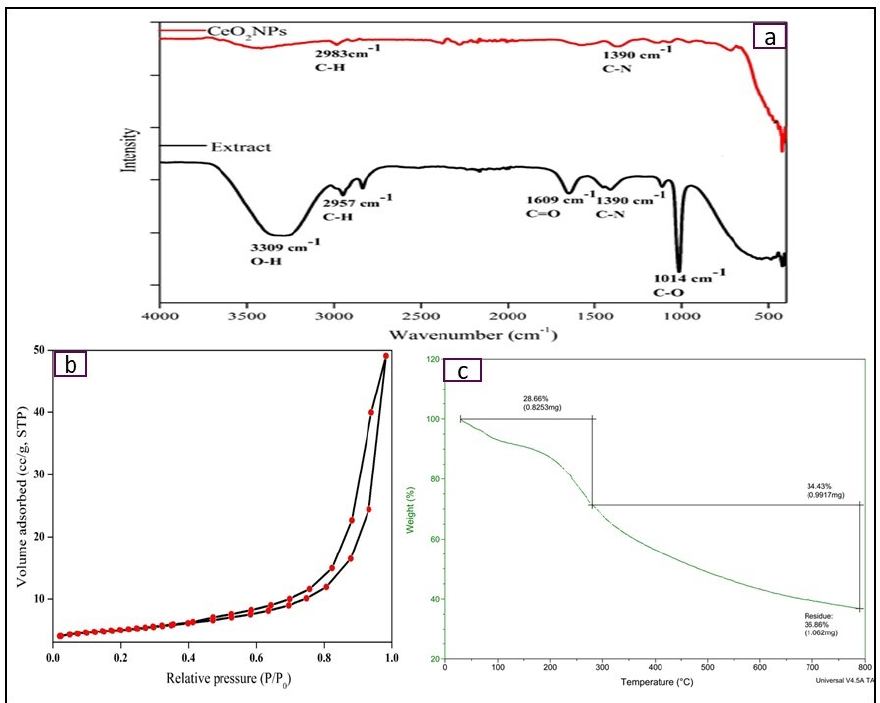
Figure 5. ( a ) Nitrogen adsorption–desorption isotherm of CeO 2 NPs; ( b , c ) TGA thermogram of Figure 5. (a) Nitrogen adsorption–desorption isotherm of CeO 2 NPs; (b,c) TGA thermogram of CeO 2 CeO 2 NPs.